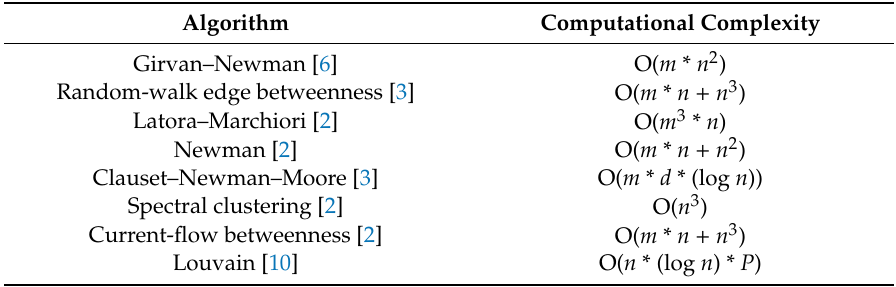
Table 1. Computation complexity on sparse networks per classic community algorithm, where n depicts the number of nodes, m the number of edges, d the depth of the dendrogram and P the number of